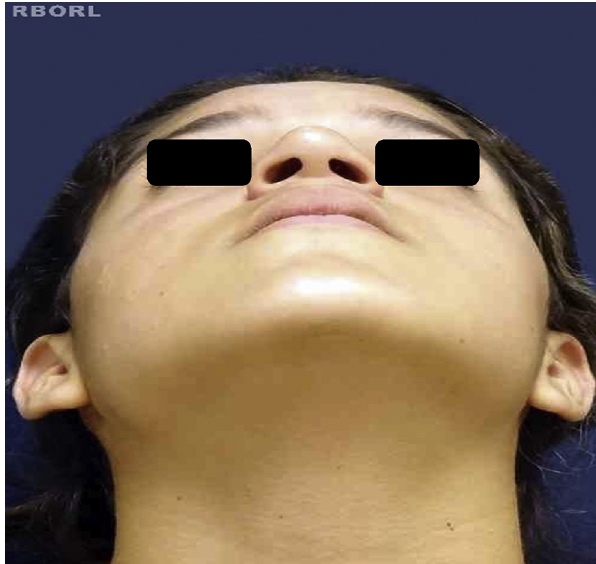
Figure 6 Postoperative nasal base